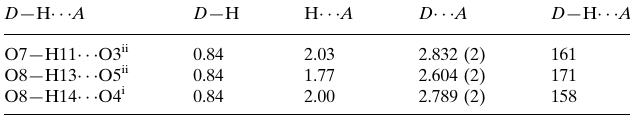
Hydrogen-bond geometry (A˚ , (cid:2)